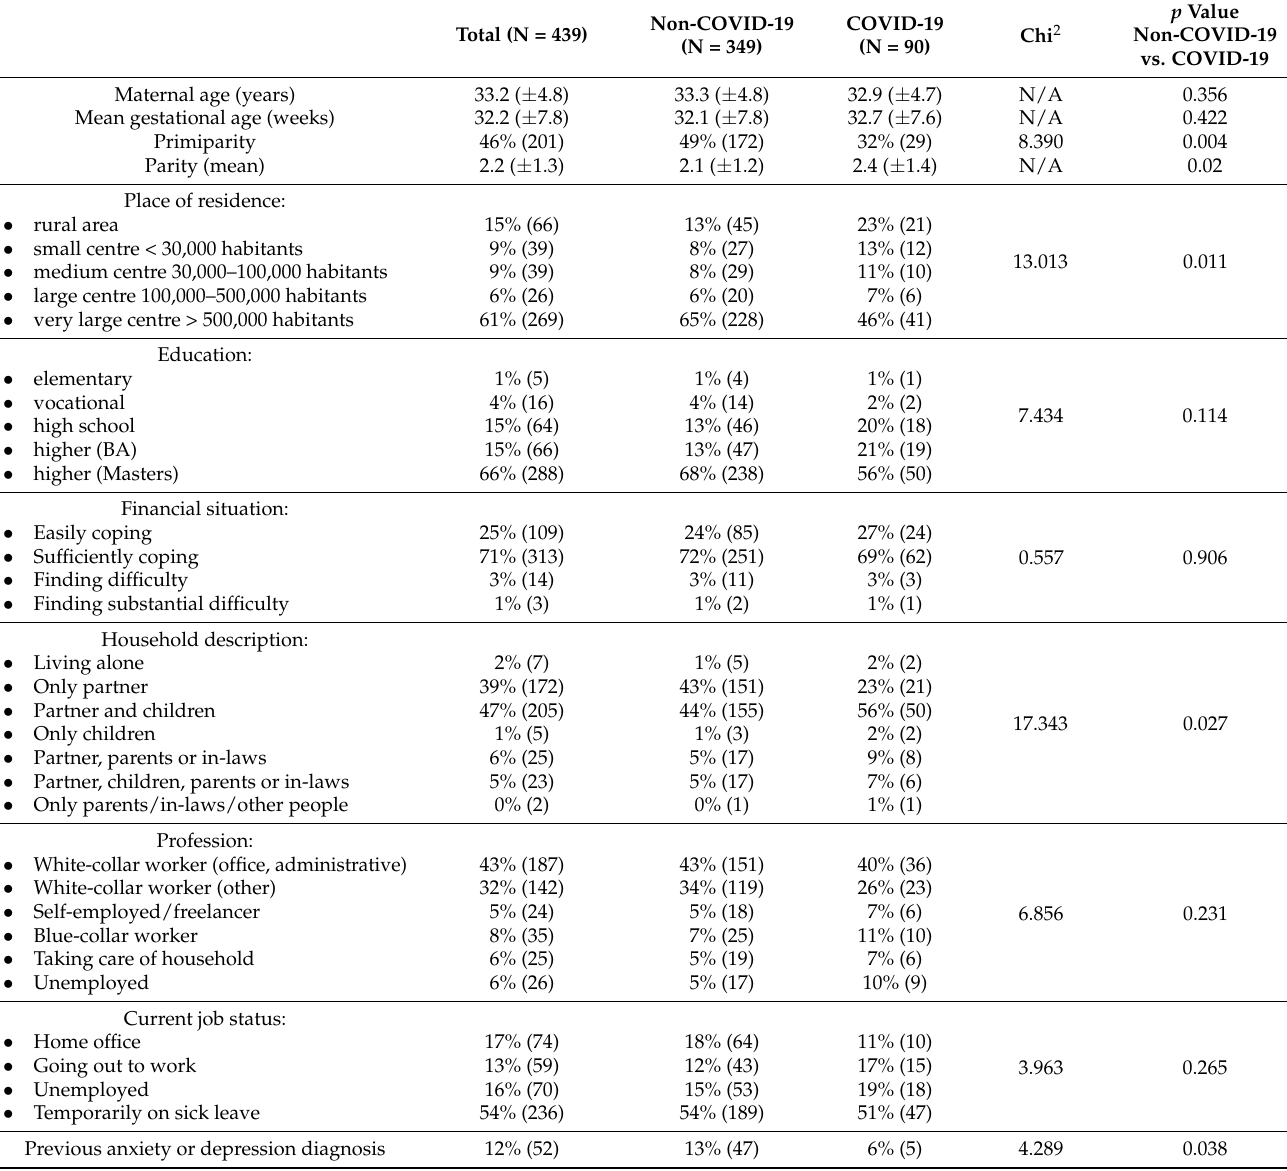
Table 2. Demographic characteristic of the study